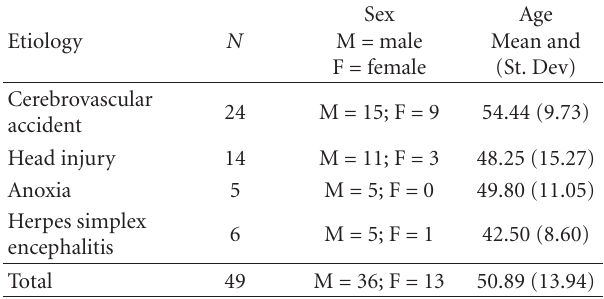
Table 1: Patient characteristics and cause of brain